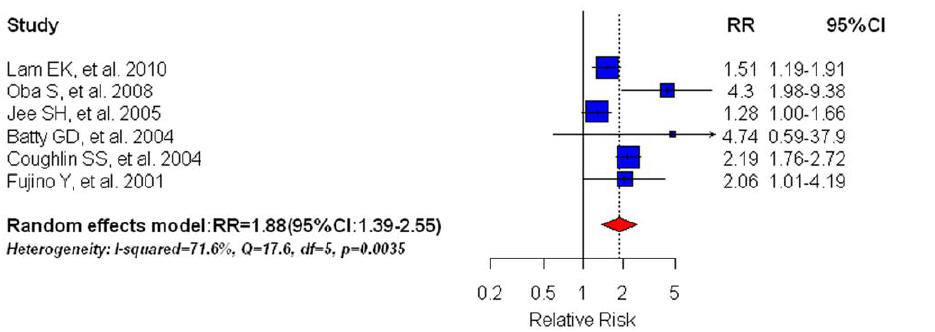
Figure 3. Summary estimate of relative risk (RR) for HCC specific mortality in diabetic patients compared with their non-diabetic counterparts. Squares represent study-specific estimates (size of the square reflects the study-specific statistical weight, i.e. inverse of the variance); horizontal lines represent 95% CIs; diamonds represent summary estimates with corresponding 95% CIs.